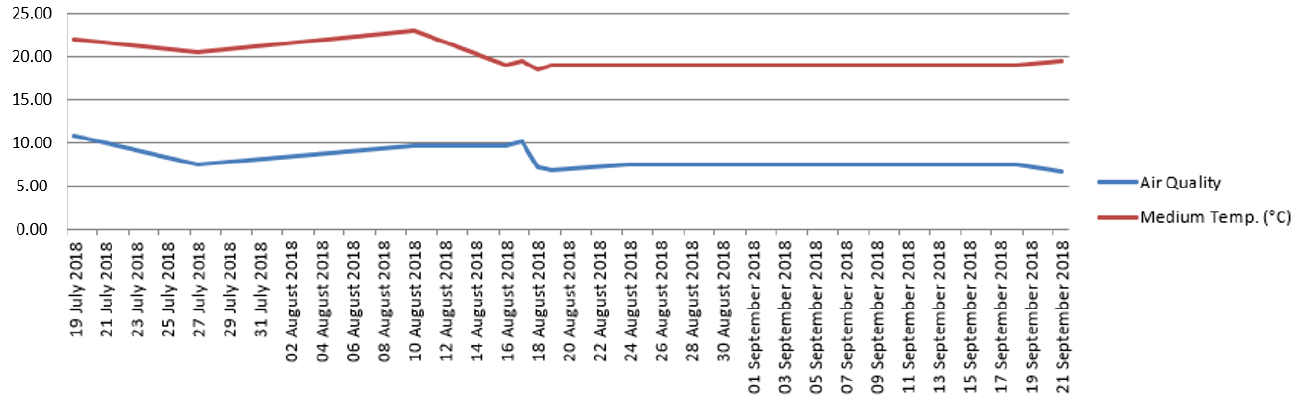
Figure 11. Line graph of air quality and temperature data